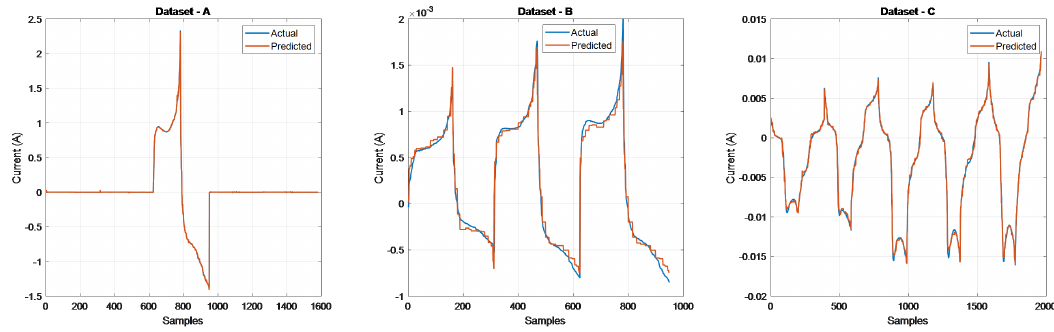
Figure 19. Actual vs Predicted performance tracking plots of the datasets.